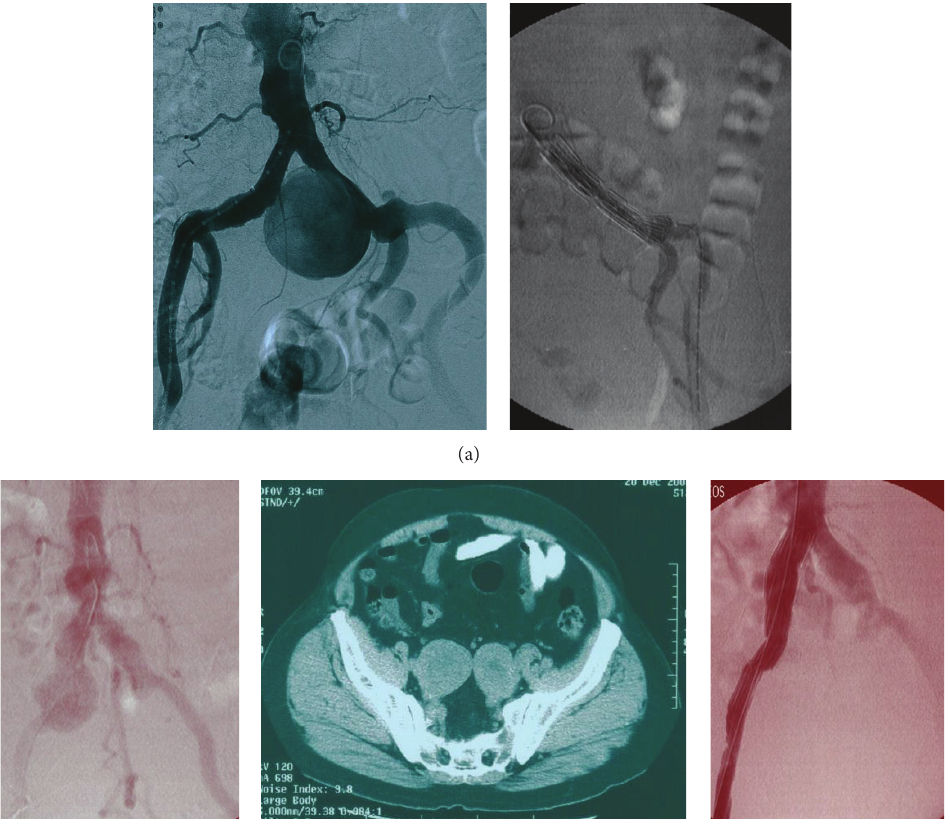
Figure 1: (a) Left common iliac artery aneurysm with large aneurysm’s neck before and after implantation angiography; two concentric stents were inserted. (b) Right common iliac artery aneurysm with rich aortic collaterals and bilateral automatically thrombosed iliac artery aneurysms; an inverted stent-graft was